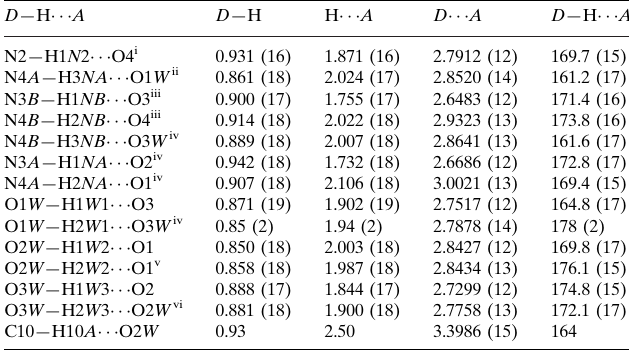
Hydrogen-bond geometry (A˚ , (cid:4)